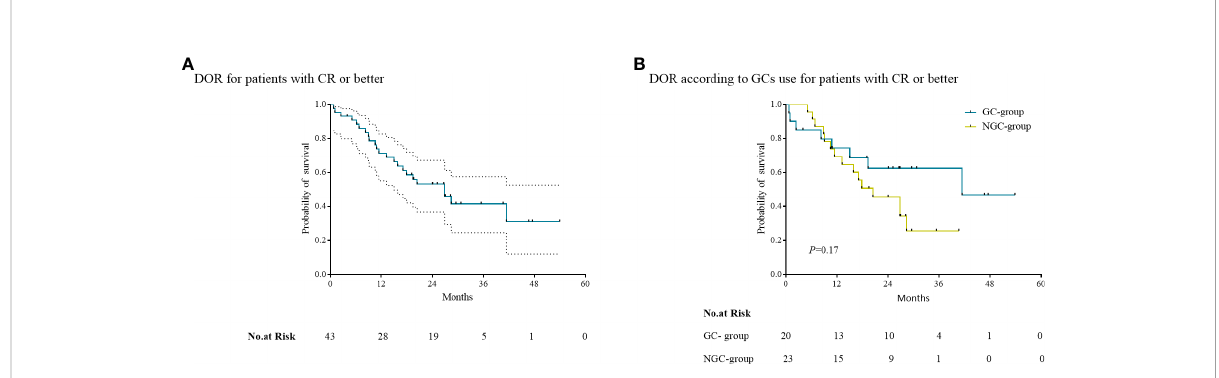
FIGURE 2 Kaplan – Meier curves of the duration of response (DOR). (A) The median DOR for patients with CR or better. (B) The median DOR for patients according to the use of GCs in patients with CR or better.